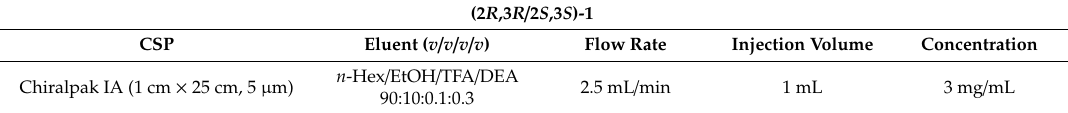
Figure 4. Analytic separation of trans- 1 on Chiralpak IA; eluent: n-Hex / IPA / DEA / TFA (90:10:0.1:0.3, v / v / v / v ), flow rate: 1 mL / min, ( a ) UV trace (detection at 220 nm), ( b ) ECD trace (detection at 240 nm). Table 2. (Semi)-preparative HPLC parameters for separating the enantiomers of trans-